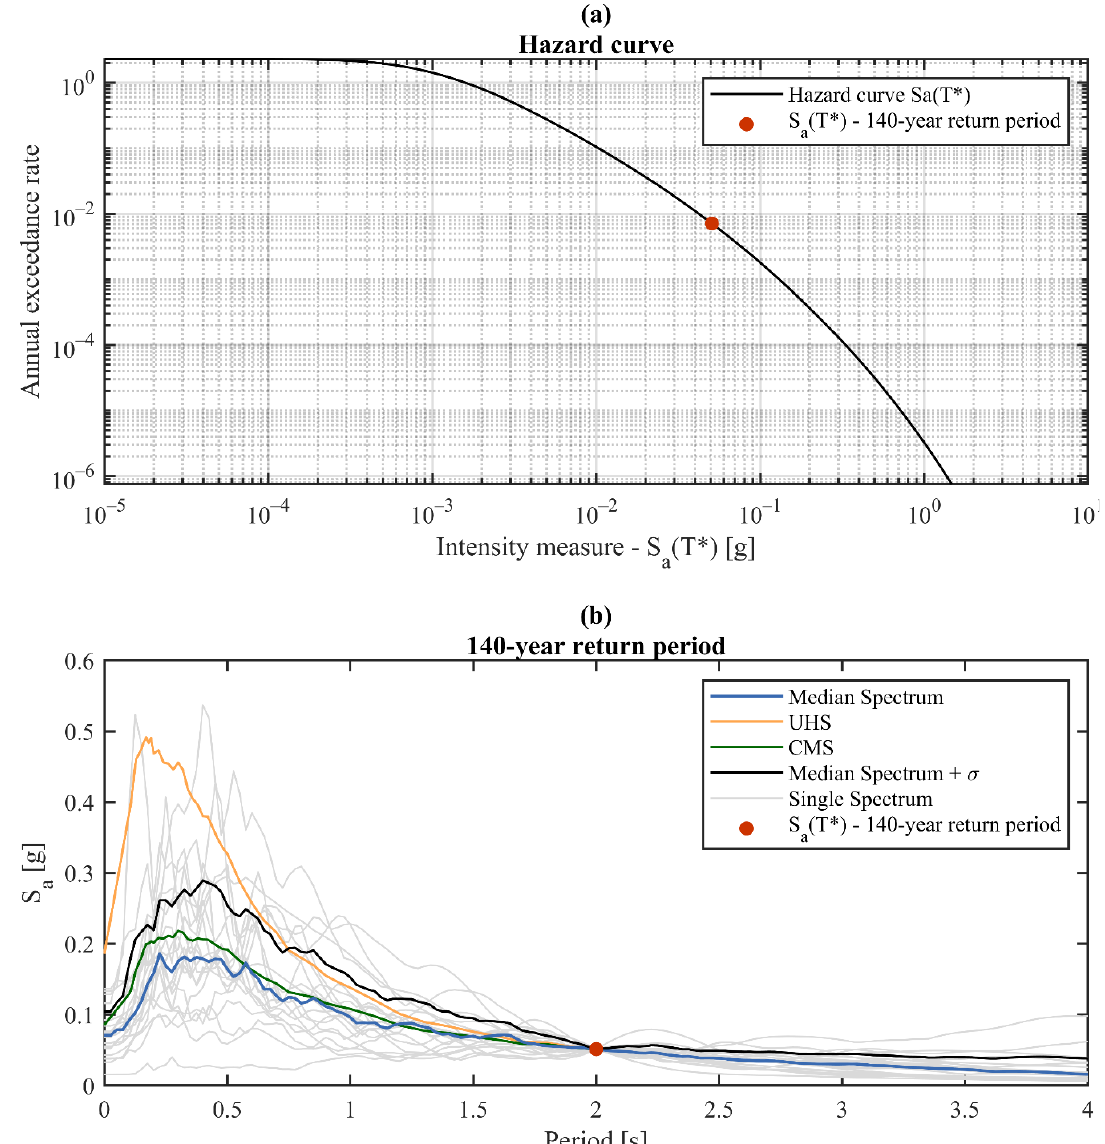
Figure 3. ( a ) Site hazard curve at the conditioning period T* = 2.0 s; and ( b ) ground motion records selected for 140-year return period.